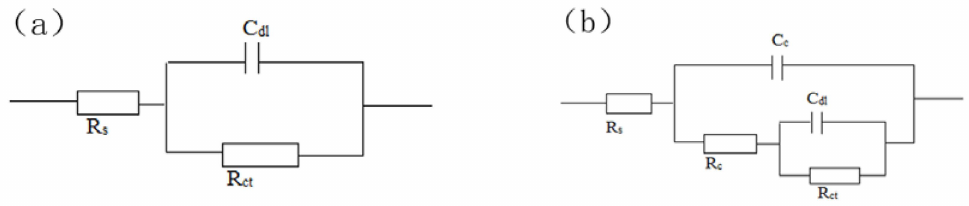
Figure 5. The equivalent circuits to fit long-term EIS results for: ( a ) early stage; ( b ) middle-late